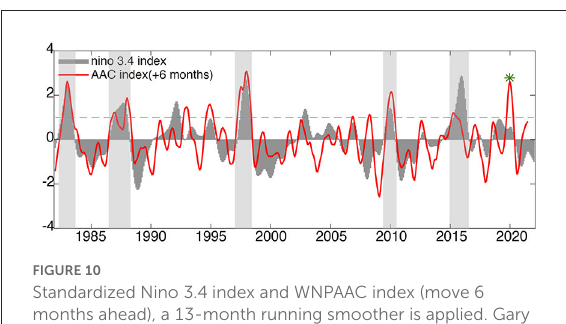
FIGURE10 Standardized Nino 3.4 index and WNPAAC index (move 6 months ahead), a 13-month running smoother is applied. Gary shadings represent the strong ENSO events. SST is from OISST. Wind is from ERA5. The anomalies are relative to